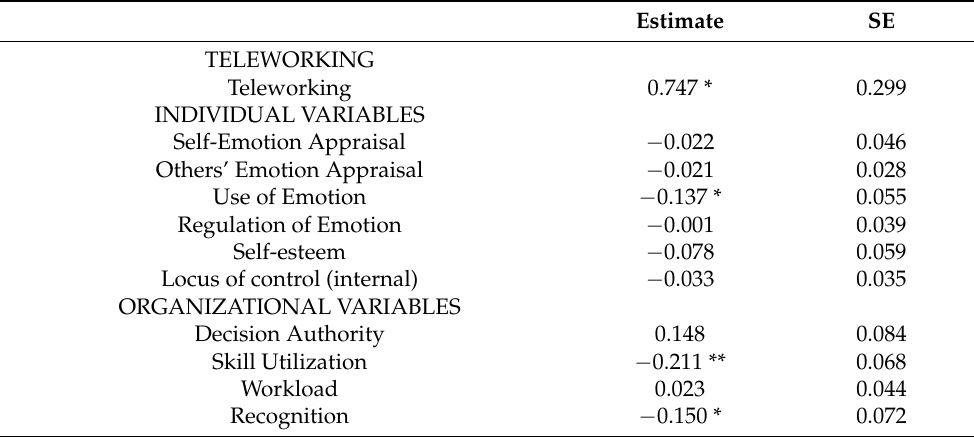
Table 3. Indirect Effects of Teleworking, Individual, and Organizational Variables on Intention to